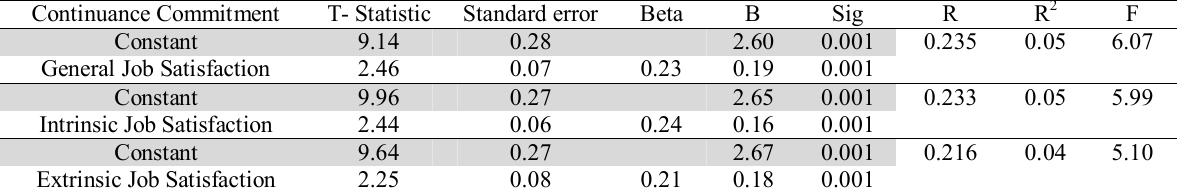
The regression analysis for predicting effect of intrinsic, extrinsic and general satisfaction on continuance commitment Continuance Commitment